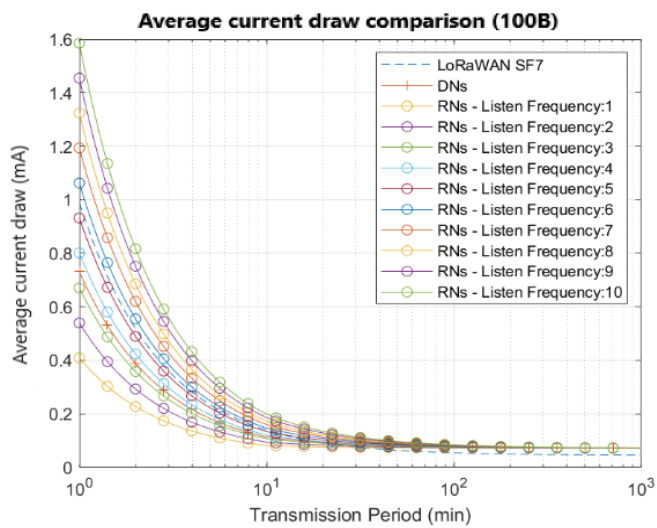
Figure 9. Average current draw in function of transmission period for applications with payloads of 100 bytes .